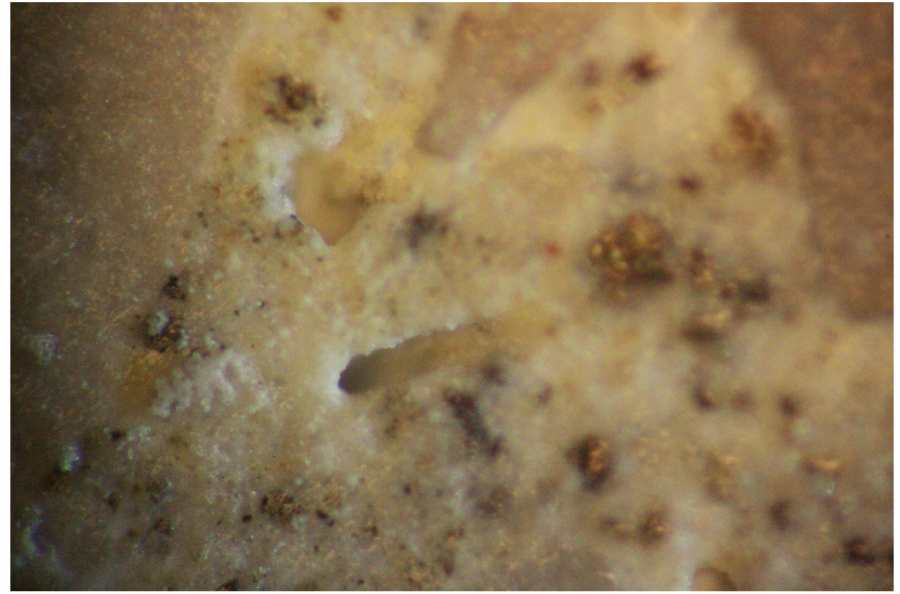
Figure 10. PP specimen after exposure to 400 ◦ C under a polarization microscope (BK-POLR, magnification 200 ×